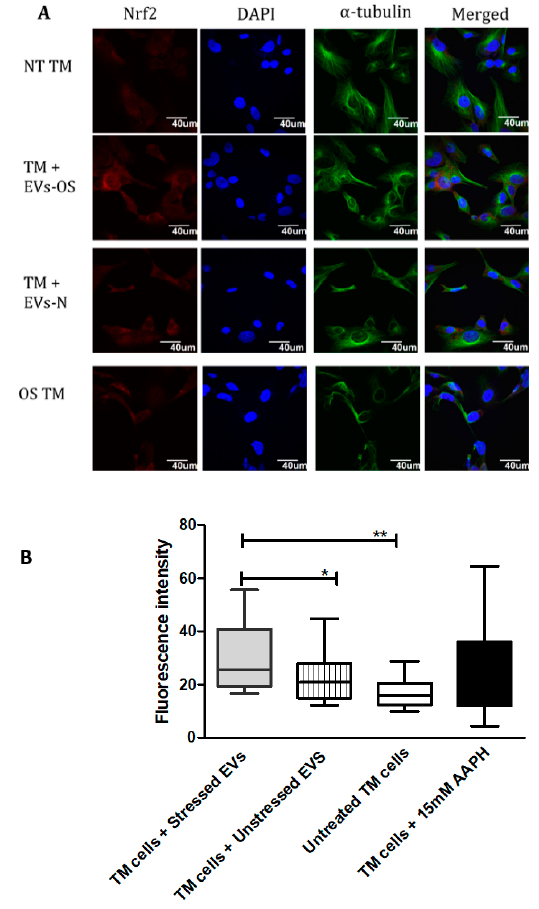
Figure 4. Immunocytochemical detection of Nrf2 in TM cells under normal or stress conditions following exposure to NPCE-derived EVs. ( A ) Representative confocal images of Nrf2 staining in untreated TM cells or TM cells co-incubated with NPCE EVs released under normal or OS conditions, or TM subjected to OS with 15 mM AAPH for 1.5 h. TM cells were co-stained with antibody against the cytoskeleton marker α -tubulin (green) and nuclei were stained with DAPI (blue) ( B ). Quantification of Nrf2 expression level. Results are displayed as mean ± SEM of fluorescent intensity / number of cells, where * p < 0.05, ** p < 0.01 in one-way ANOVA with post hoc Tukey’s